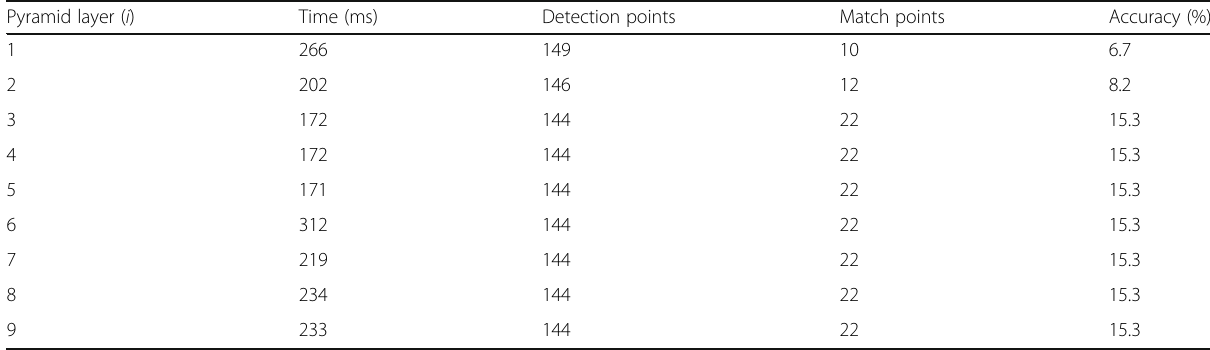
Table 6 Statistical results of the experimental results of the ever-changing pyramid layer when the scale parameter between pyramid images is